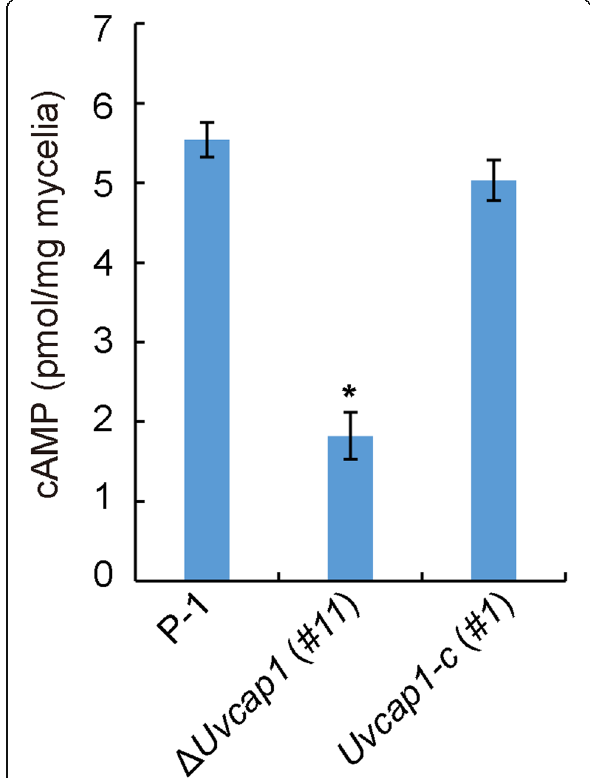
Fig. 7 UvCap1 affects the intracellular cAMP content in U. virens. The intracellular cAMP level in wild-type strain P-1, the Δ Uvcap1 ( #11 ) mutant and its complemented strain Uvcap1-c ( #1 ) was detected. Error bars represent SD. * indicates significant differences between the mutant and the wild-type/or complemented strains as estimated by Duncan ’ s new multiple range test ( P < 0.05) caused by this mutant are significantly reduced com- pared with those by the wild-type strain (Zhou et al.